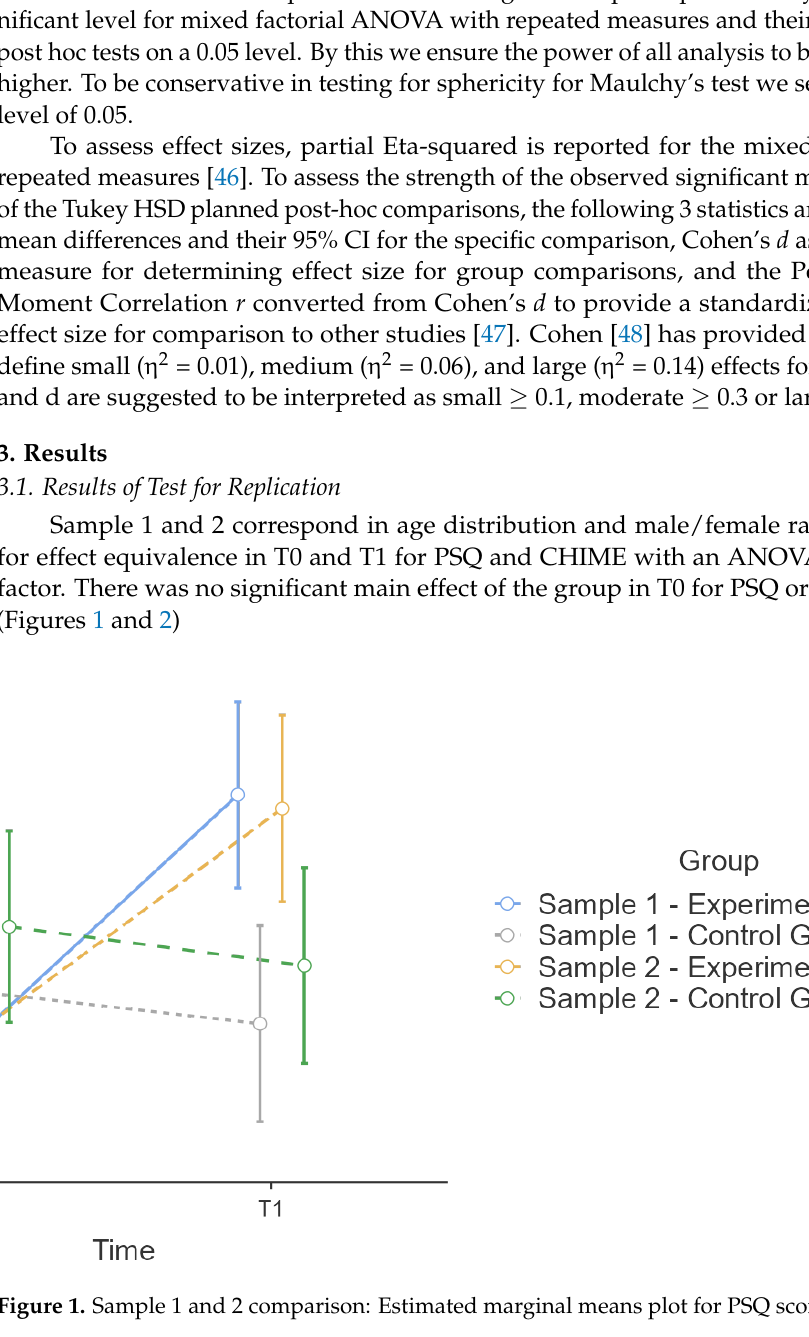
Figure 1. Sample 1 and 2 comparison: Estimated marginal means plot for PSQ score.